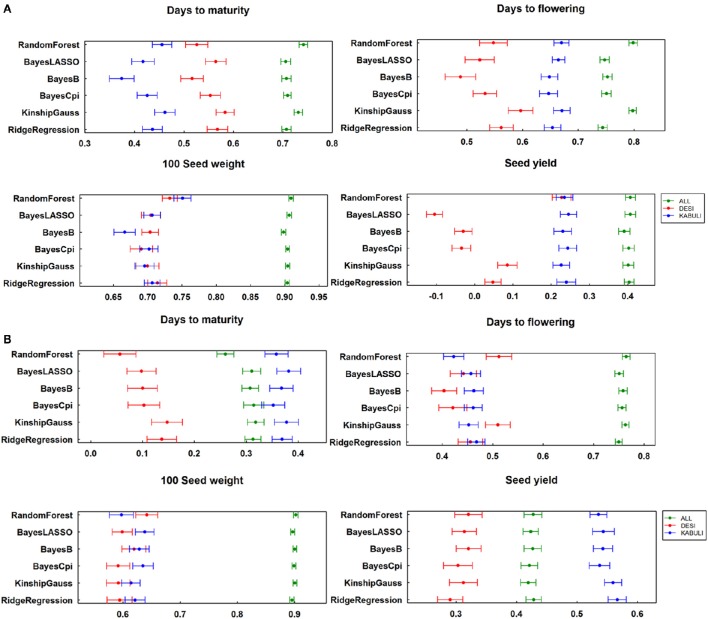
Regression of true breeding value on breeding values estimated with different methods (A) for ICRISAT location; (B) for IARI location.